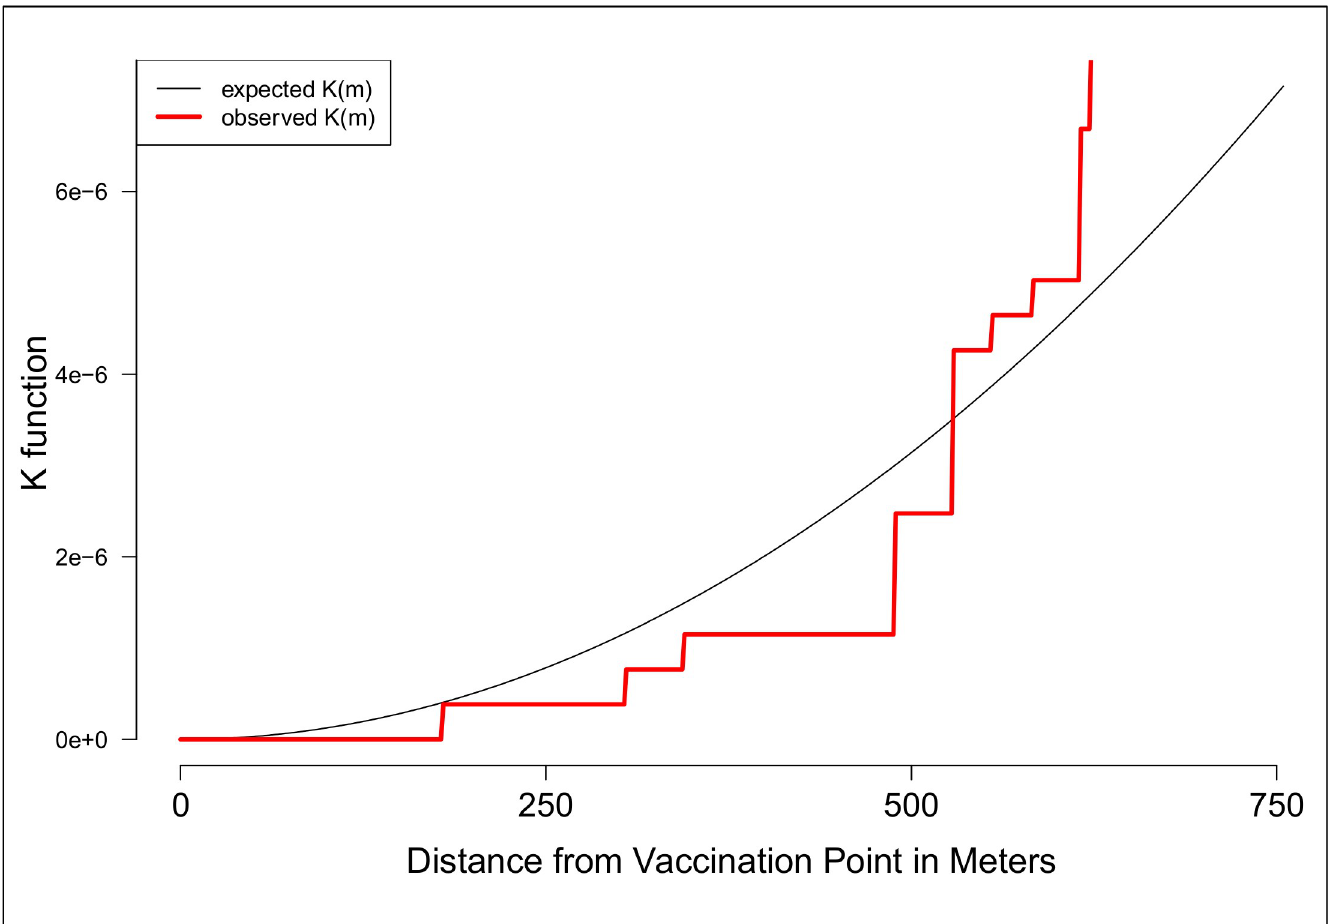
Fig 2. Clustering of unvaccinated dogs as a function of distance from the dog owner’s house to the closest vaccination point.